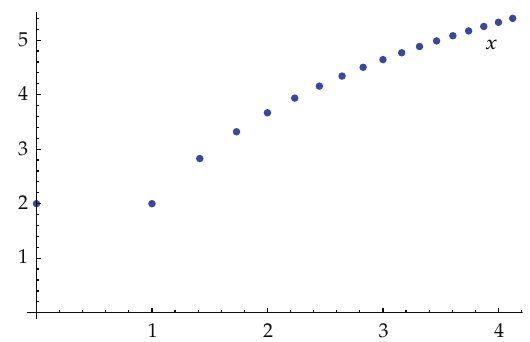
Figure 2: The graph of 15 iterates for the solution of (cid:2) 6.5 (cid:4) illustrates the result of Theorem